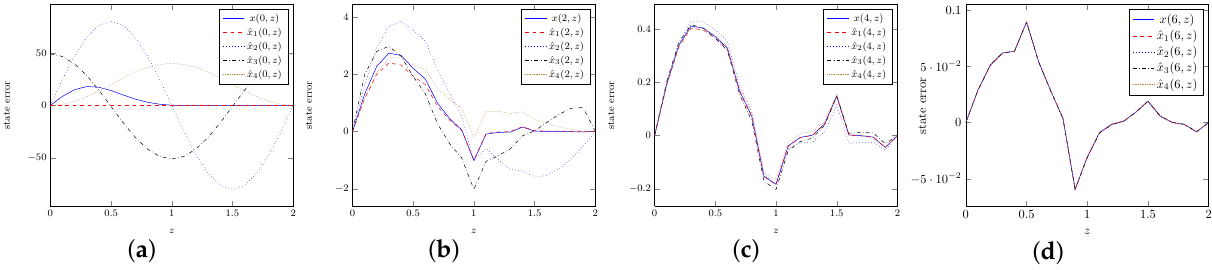
Figure 3. The spatial states distribution of the actual system and the four estimators at four different times. ( a ) t = 0 s. ( b ) t = 2 s. ( c ) t = 4 s. ( d ) t = 8 s.